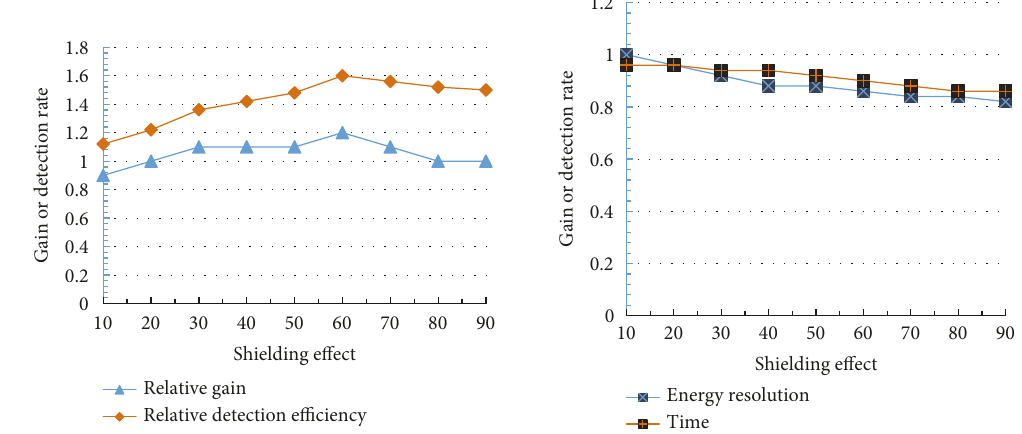
Figure 9: Testing of different parameters in different magnetic field intensities.